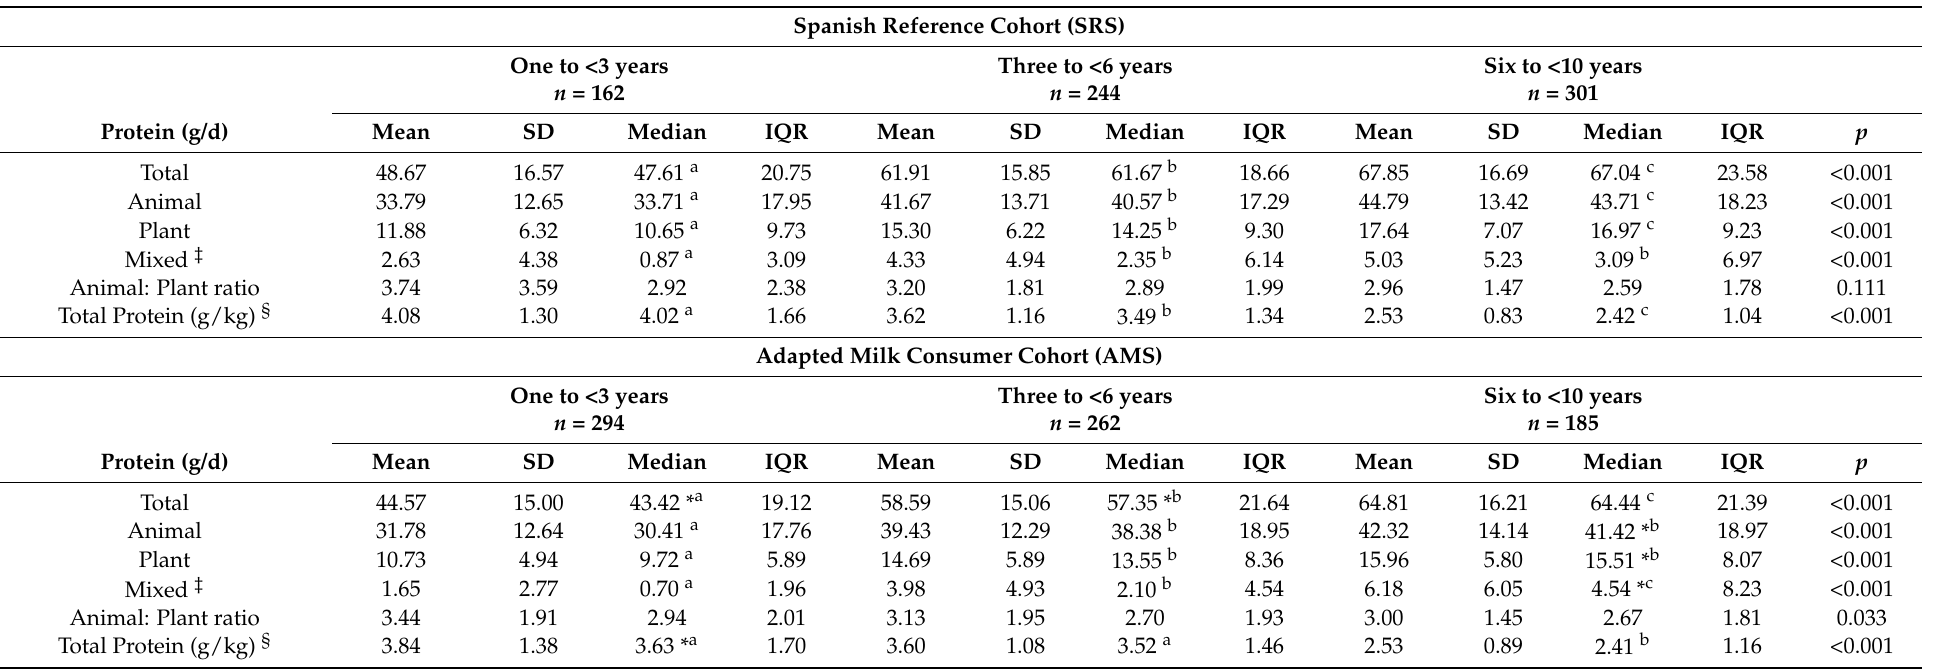
Table 2. Total, animal, plant, and mixed protein intakes by age and cohort from the Nutritional Study in the Spanish Pediatric Population (EsNuPI) ( n =